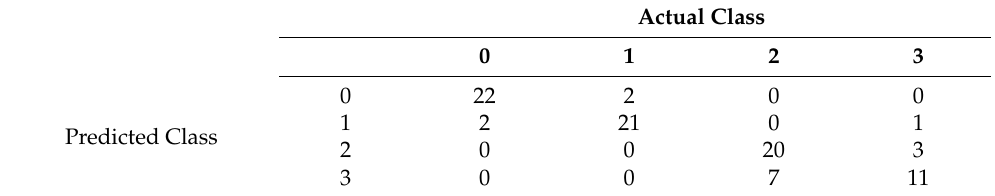
Table 8. Confusion matrix for the primal simplex algorithm execution time.